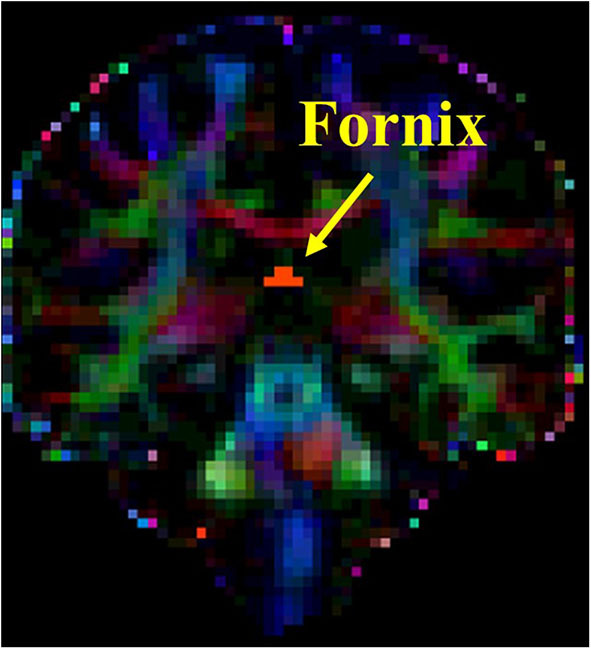
Seed placement for tractography of fornix.